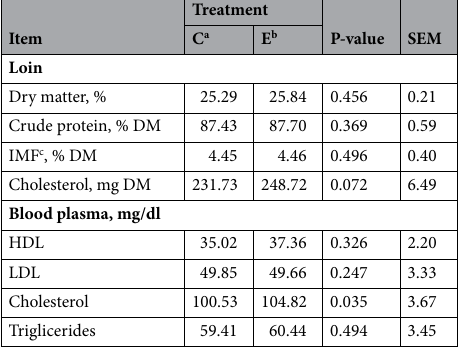
Table 4. Chemical composition of raw loin and blood lipid profile of pigs. a Control group fed complete mixtures without halloysite. b Experimental group fed complete mixtures with halloysite addition. c Intramuscular fat.